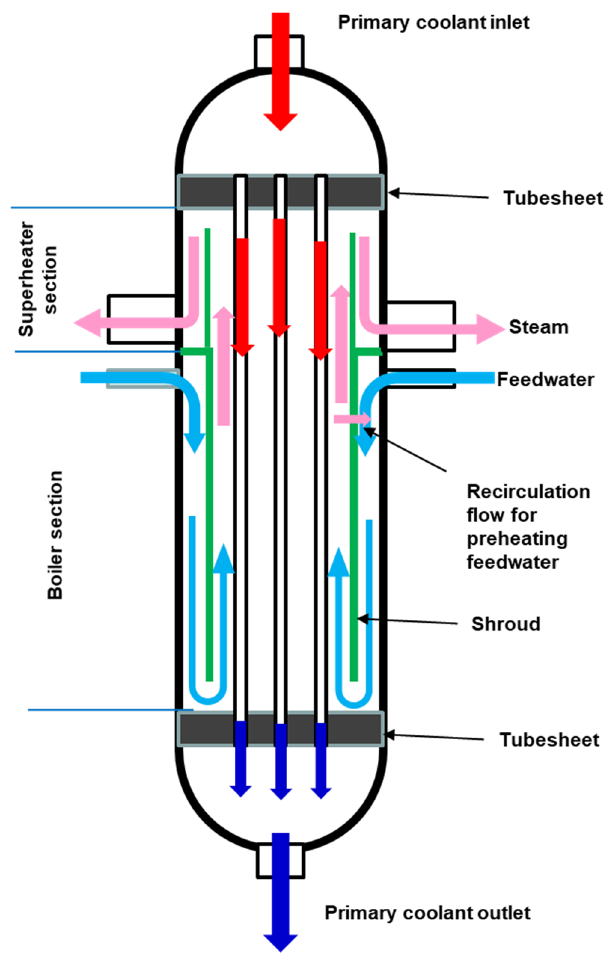
Figure 2. Conceptual scheme for once through steam generator [21]. Table 5. Main features of an OTSG.